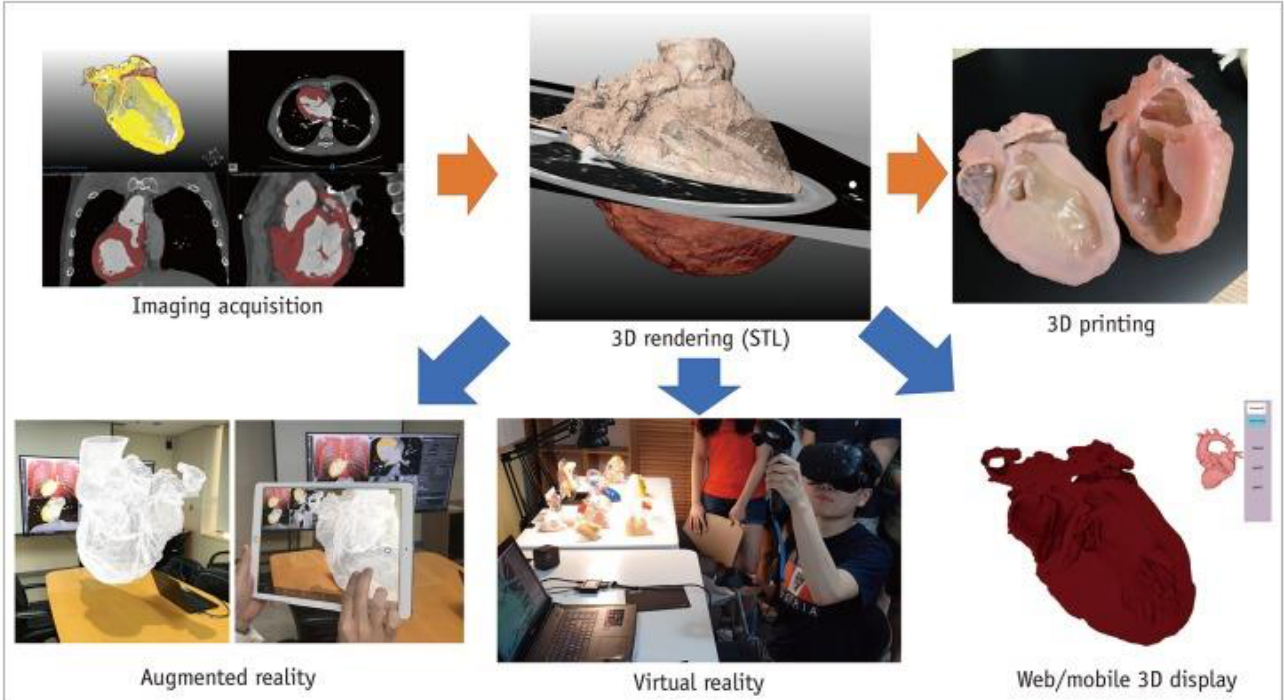
Figure 8. Workflow of advanced visualization technology. Segmented 3D volume data can be used for 3D printing, virtual reality, augmented reality and interactive or mobile 3D displays. Reprinted with permission under the open access from Goo et al. [60].